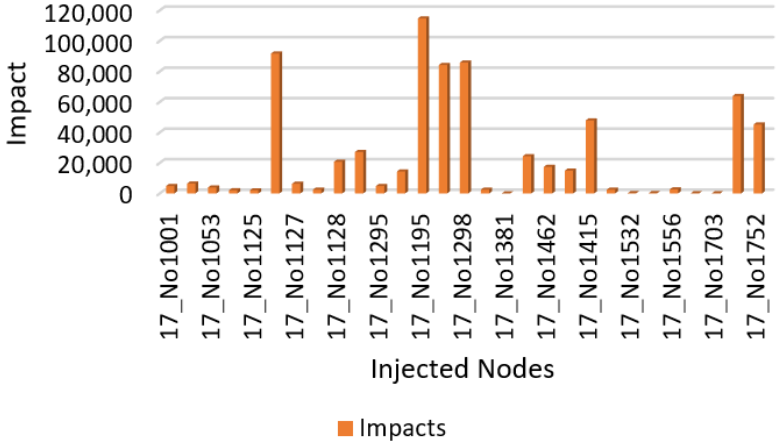
Figure 10. Health impact without using water quality